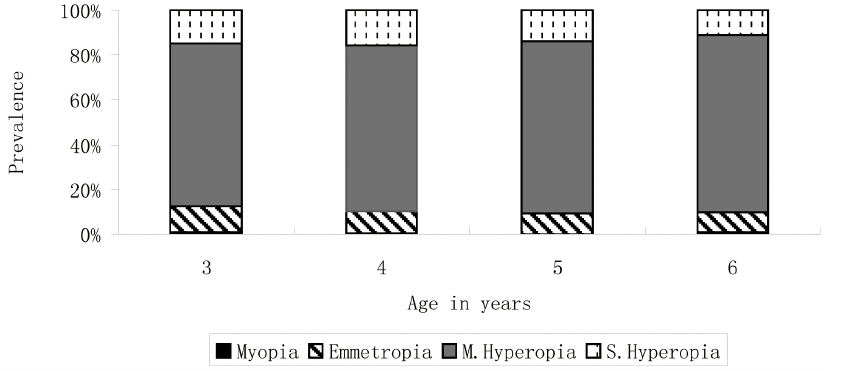
Figure 3. Prevalence of refractive categories by age. To facilitate comparison, definitions identical to those used in a comprehensive analysis of the distributions of refraction error from all the RESC studies [27]are used in this figure. Myopia: , /= 2 0.5 D, Emmetropia: .2 0.5 to , /= + 0.5 D, Mild Hyperopia (M. Hyperopia): . + 0.5 to , /= + 2.0 D, Significant Hyperopia (S. Hyperopia): . + 2.0 D. doi:10.1371/journal.pone.0078003.g003 PLOS ONE |